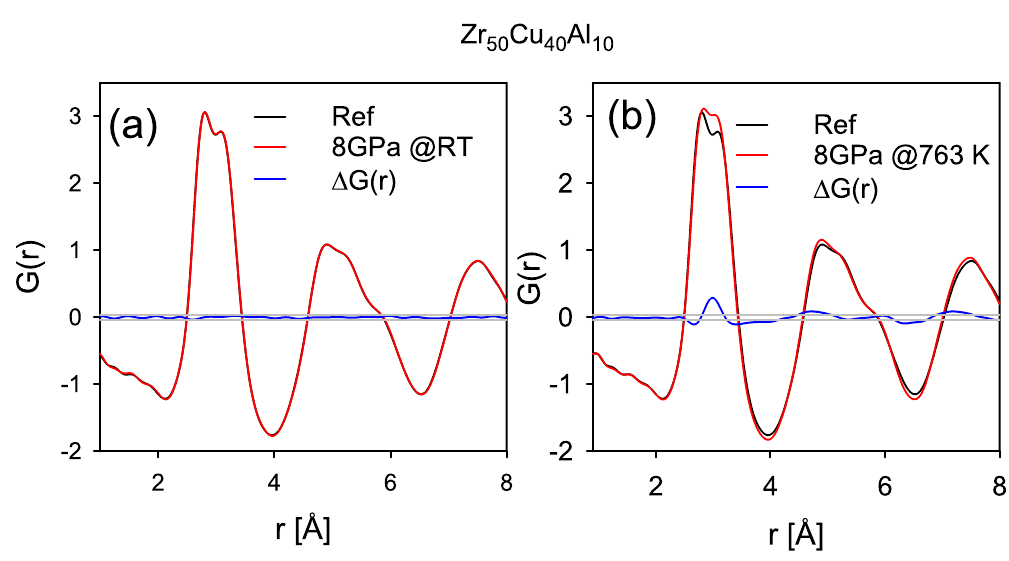
Figure 3. ( a , b ) G ( r )’s for the glass that was ( a ) compressed to 8 GPa at RT and then decompressed and ( b ) quenched from 763 K at 8 GPa and then decompressed at RT. The difference in G ( r ) from the reference sample is plotted in blue line. Thin gray band denotes two standard deviations in statistical